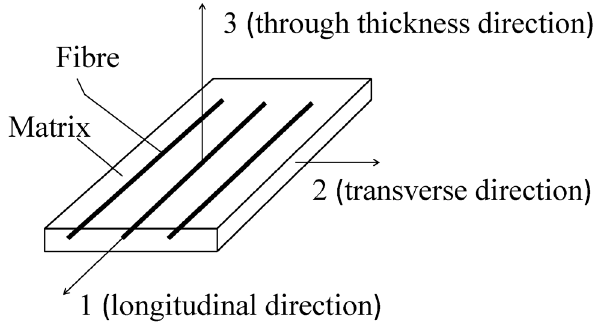
Figure 2. Lamina co ‐ ordinate system. Figure 2. Lamina co-ordinate